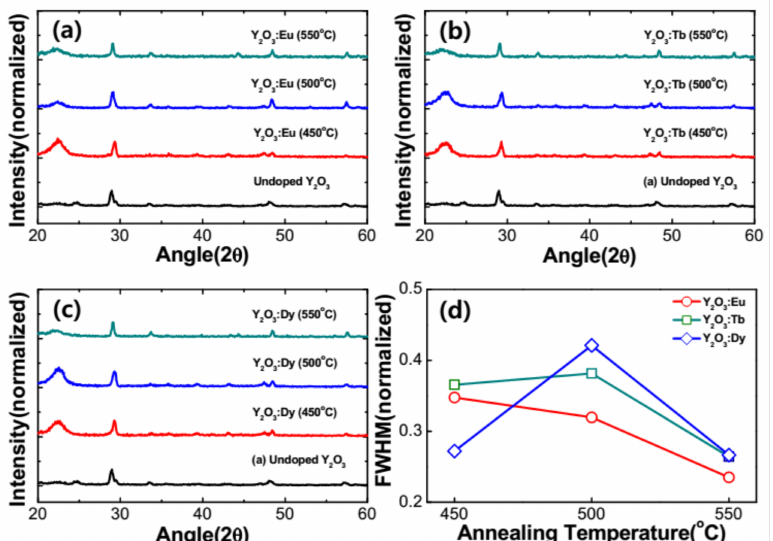
Figure 2. XRD patterns of the RE-doped Y 2 O 3 for different annealing temperatures at 450, 500, 550 ◦ C. ( a ) 0.05 mM of Eu 3+ -doped Y 2 O 3 core, ( b ) 0.05 mM of Tb 3+ -doped Y 2 O 3 core and ( c ) 0.05 mM of